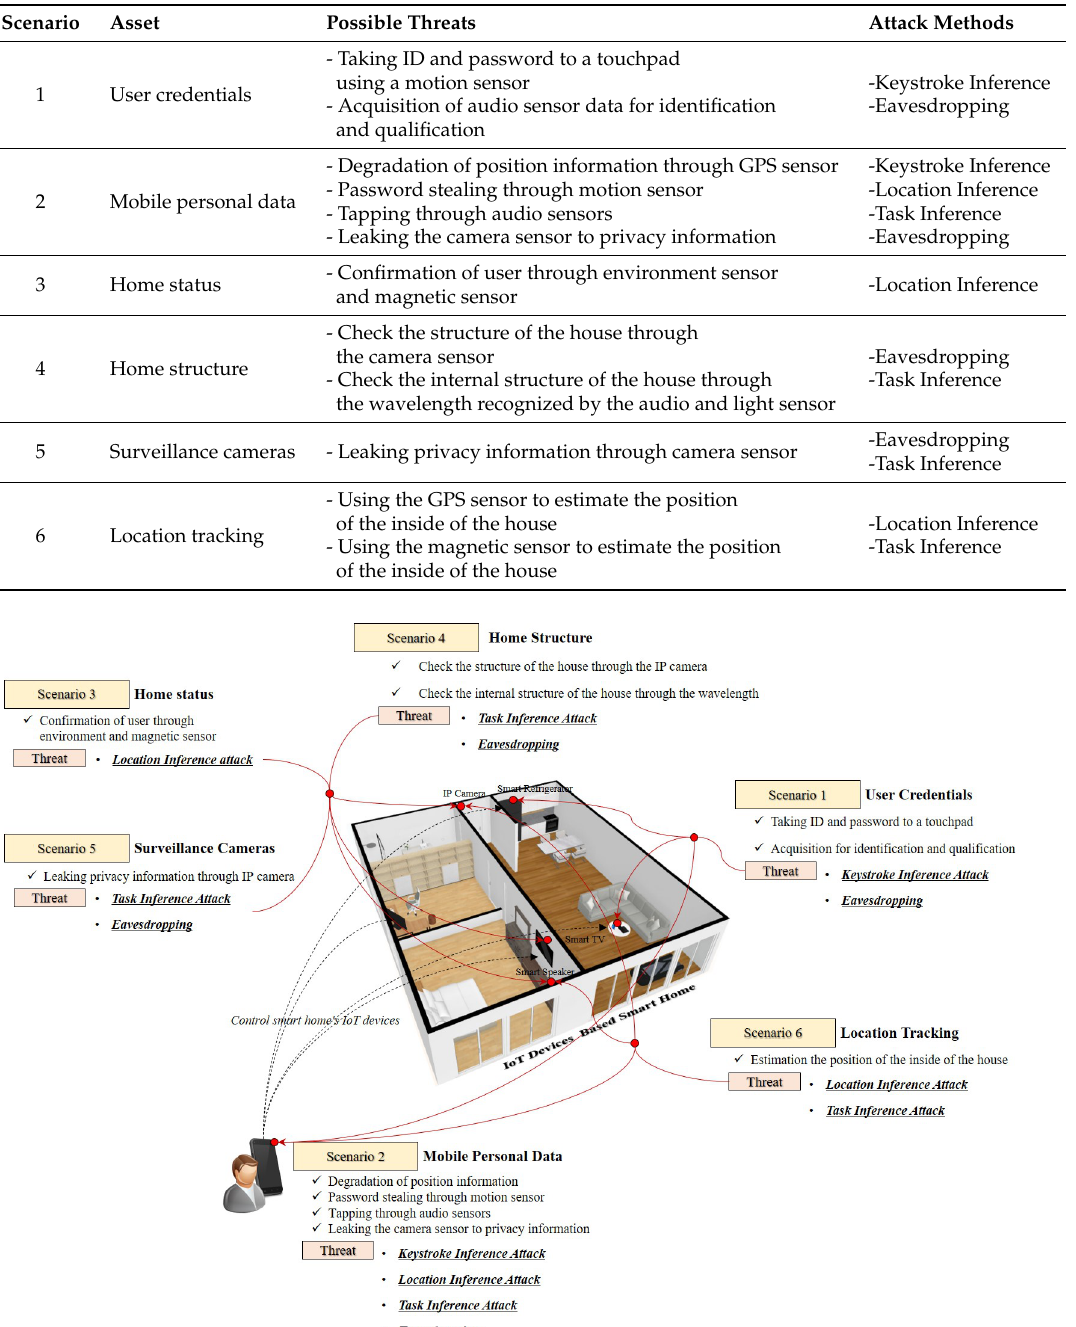
Table 2. Threats and attack methods that can occur according to information assets that create various scenarios.